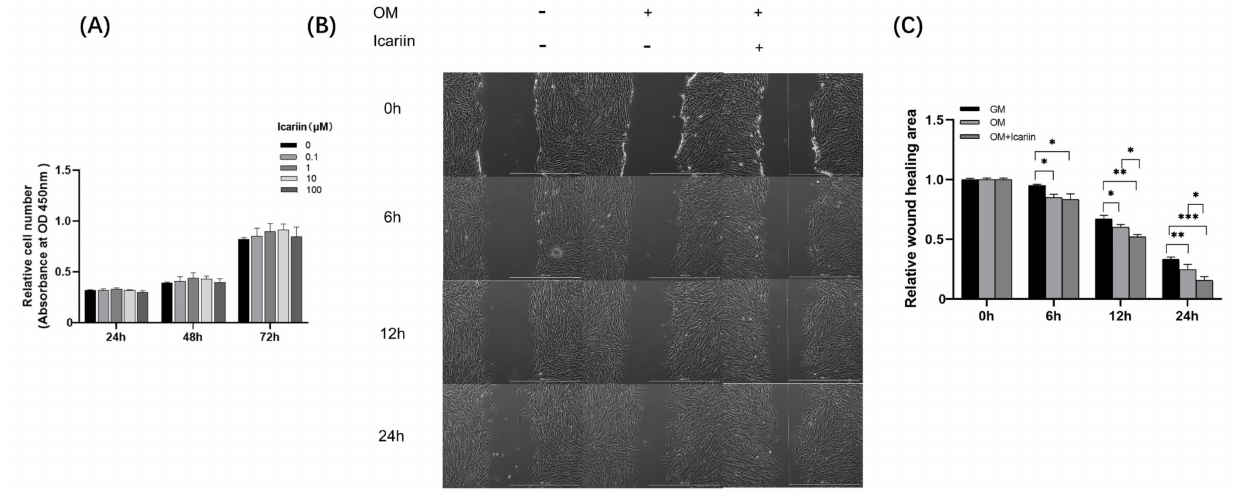
Figure 1. Effect of icariin on cytotoxicity and migration of HDPCs. ( A ) HDPCs were exposed to icariin at different concentrations for 24, 48, 72 h. Medium without icariin was used as a negative control ( p > 0.05). ( B ) HDPCs were cultured with or without 10 µ M icariin. Images of HDPCs migration were captured at 0, 6, 12, and 24 h (scale bar = 1000 µ M). ( C ) Quantitative analysis of wound migration area was normalized to GM. Bars show means ± standard deviation (* p < 0.05, ** p < 0.01, *** p < 0.001,